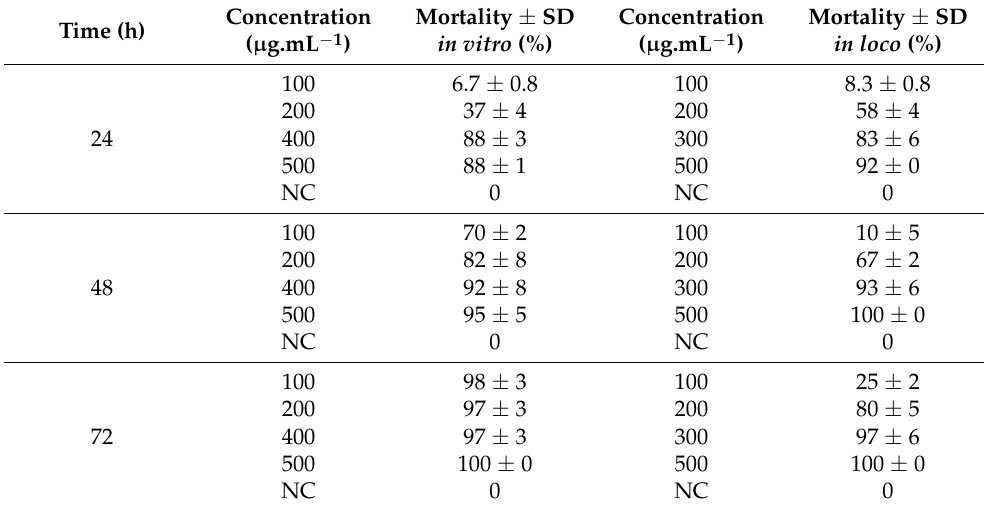
Table 4. In vitro and in loco effectiveness of the biodefensive PNE on A. aquasalis larvae. Concentration Mortality ± SD Concentration Mortality ± SD Time (h) in vitro (%) in loco (%) ( µ g.mL − 1 ) ( µ g.mL − 1 ) 100 6.7 ± 0.8 100 8.3 ± 0.8 200 37 ± 4 200 58 ± 4 24 400 88 ± 3 300 83 ± 6 500 88 ± 1 500 92 ± 0 NC 0 NC 0 100 70 ± 2 100 10 ± 5 200 82 ± 8 200 67 ± 2 48 400 92 ± 8 300 93 ± 6 500 95 ± 5 500 100 ± 0 NC 0 NC 0 100 98 ± 3 100 25 ± 2 200 97 ± 3 200 80 ± 5 72 400 97 ± 3 300 97 ± 6 500 100 ± 0 500 100 ± 0 NC 0 NC